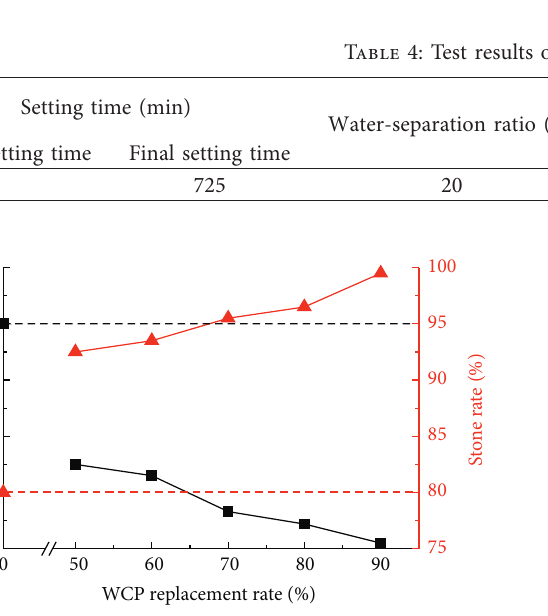
Figure 5: Water-separation ratio and stone rate at different sub- stitution rates.